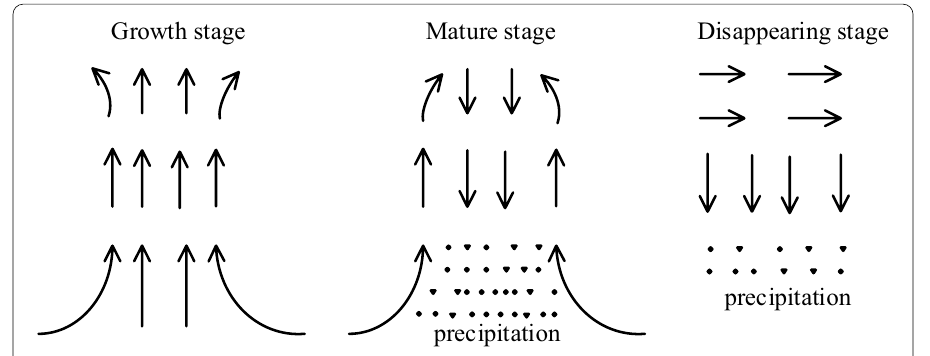
Fig. 4 The evolution process of convective